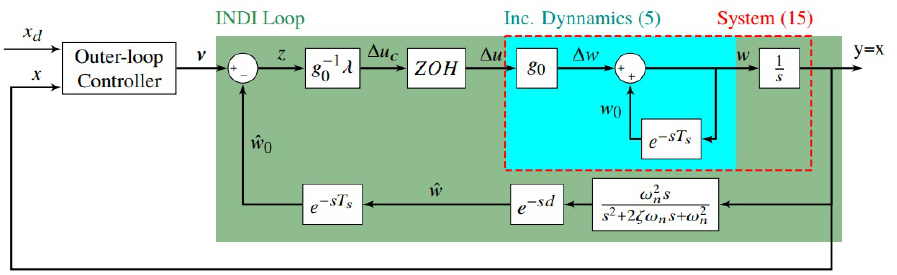
Figure 11. Block diagram of INDI controller applied to a first-order